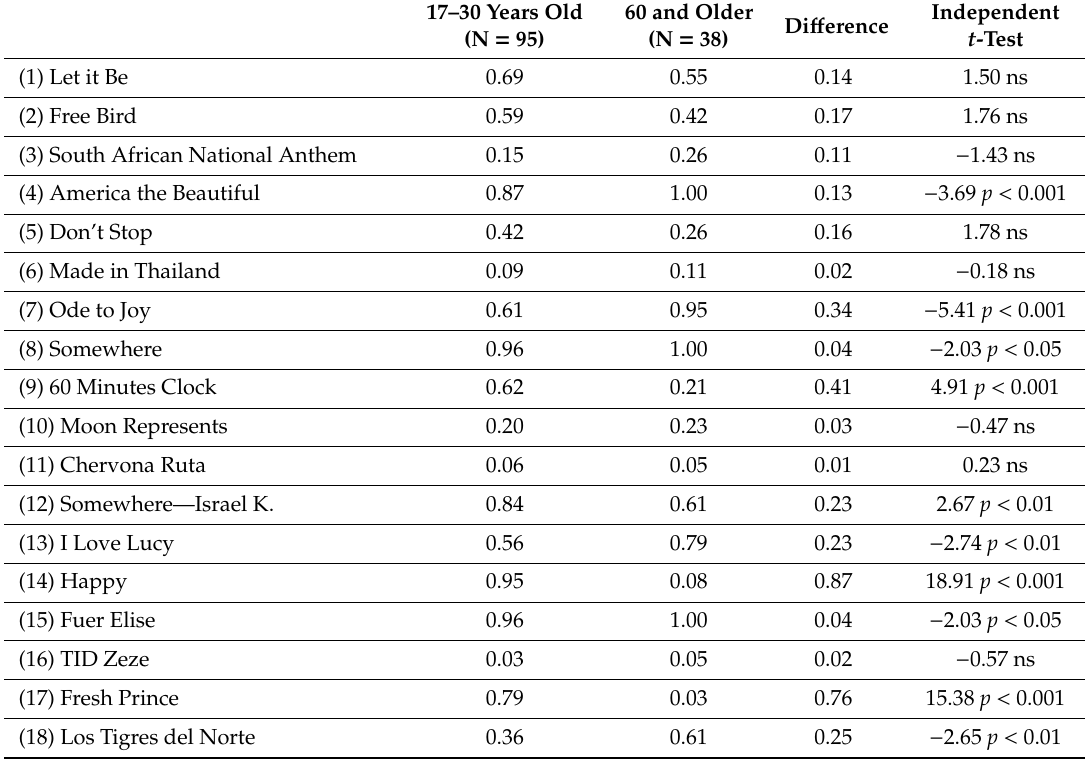
Table 6. For Americans by young and old age cohorts (N =